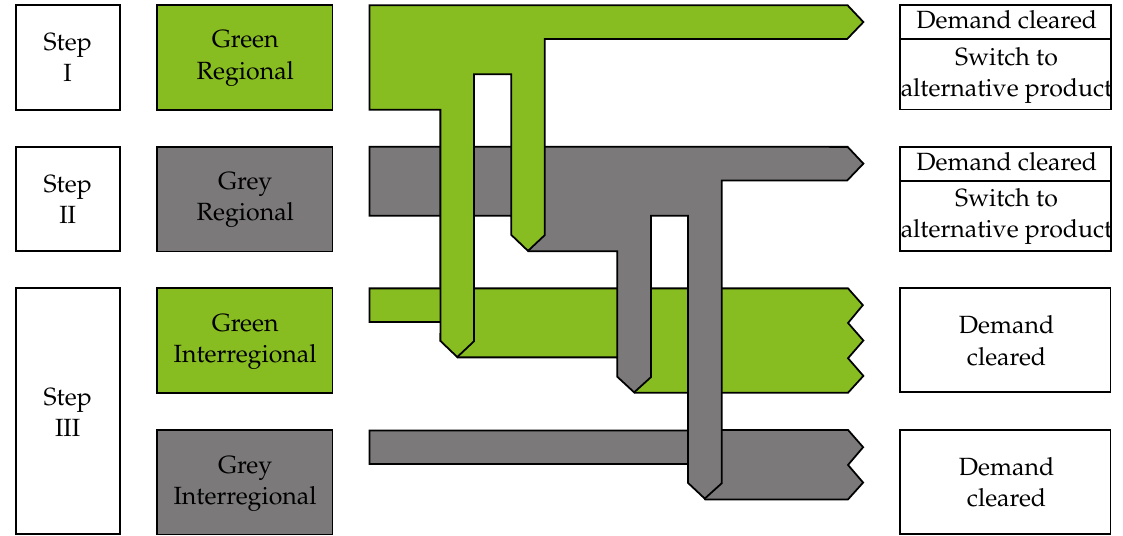
Figure 4. Market clearing scheme and alternative